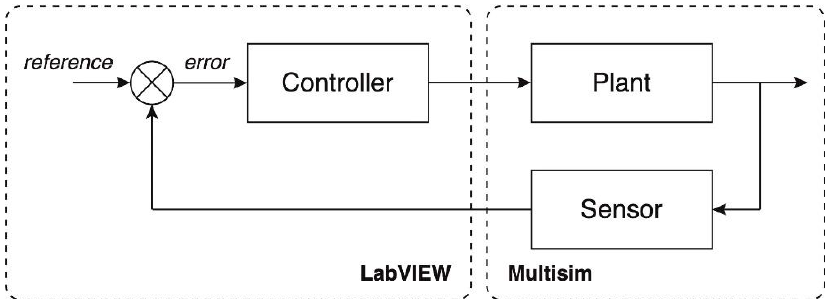
Figure 1. Co-simulation between LabVIEW(controller) and Multisim (plant and sensors).